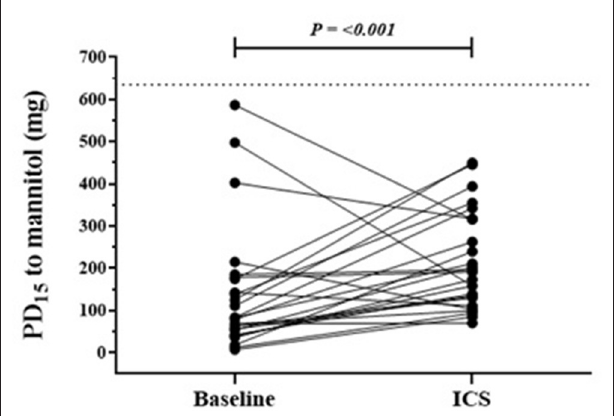
FIGURE 2 | Individual response in those with persistent AHR to mannitol following a mean of 20 weeks of daily ICS. Baseline and follow-up individual PD 15 to mannitol results in the group where AHR remained at ICS follow-up visit. n = 25, follow up mean duration 180 days. The dotted horizontal line